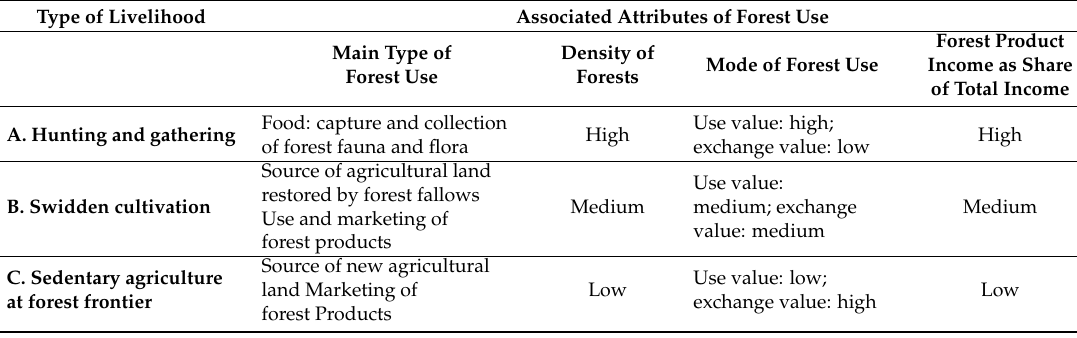
Table 1. Types of forest-based livelihoods and associated attributes of forest